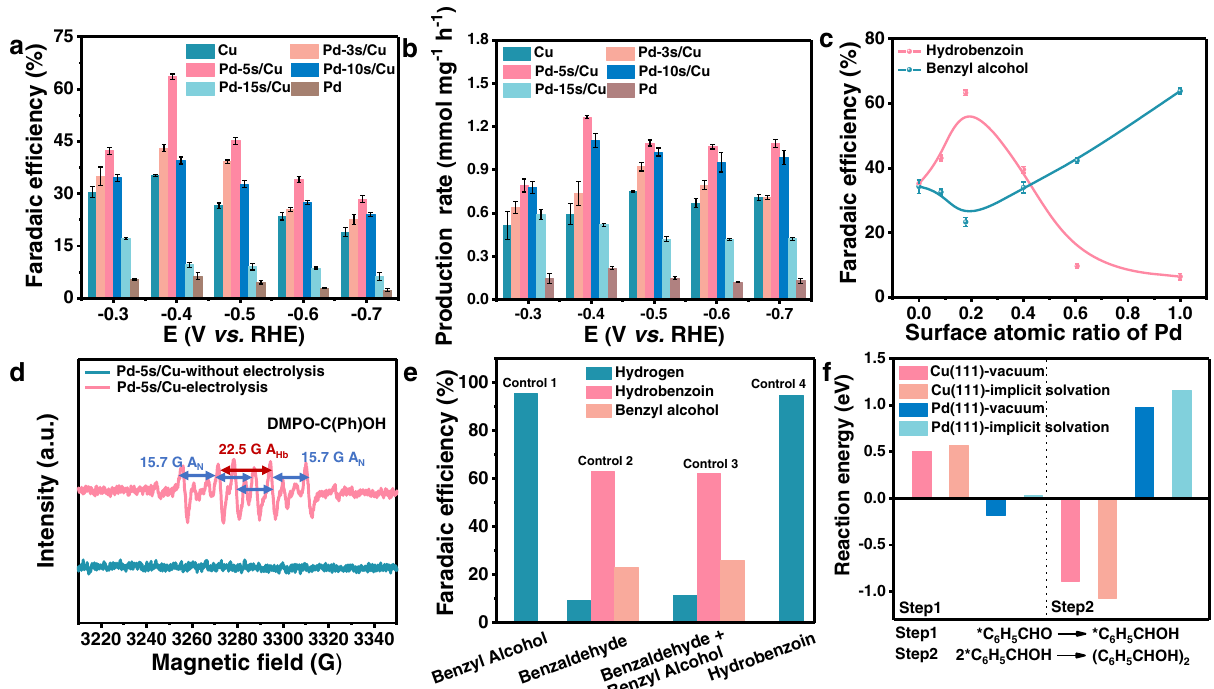
Fig. 2 | Catalytic performance of Pd/Cu catalysts and results of DFT calcula- tions. a Faradaic ef fi ciencies and ( b ) average production rates of hydrobenzoin at different potentials. c Faradaic ef fi ciencies of hydrobenzoin (pink line) and benzyl alcohol (green line) at − 0.40V vs. RHE as a function of surface atomic ratio of Pd. d EPRspectraoverPd-5s/Cuwithandwithoutelectrolysis. e Faradaicef fi cienciesof